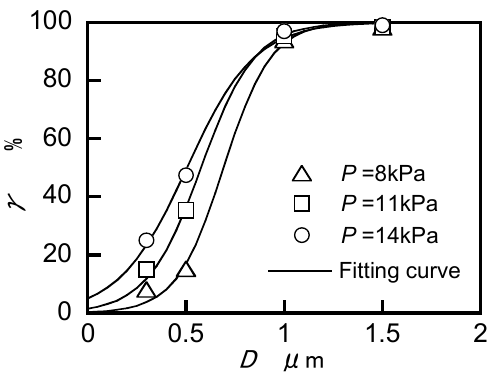
Fig. 13 Removal rates of particles dependent on particle diameter for each storage tank pressure